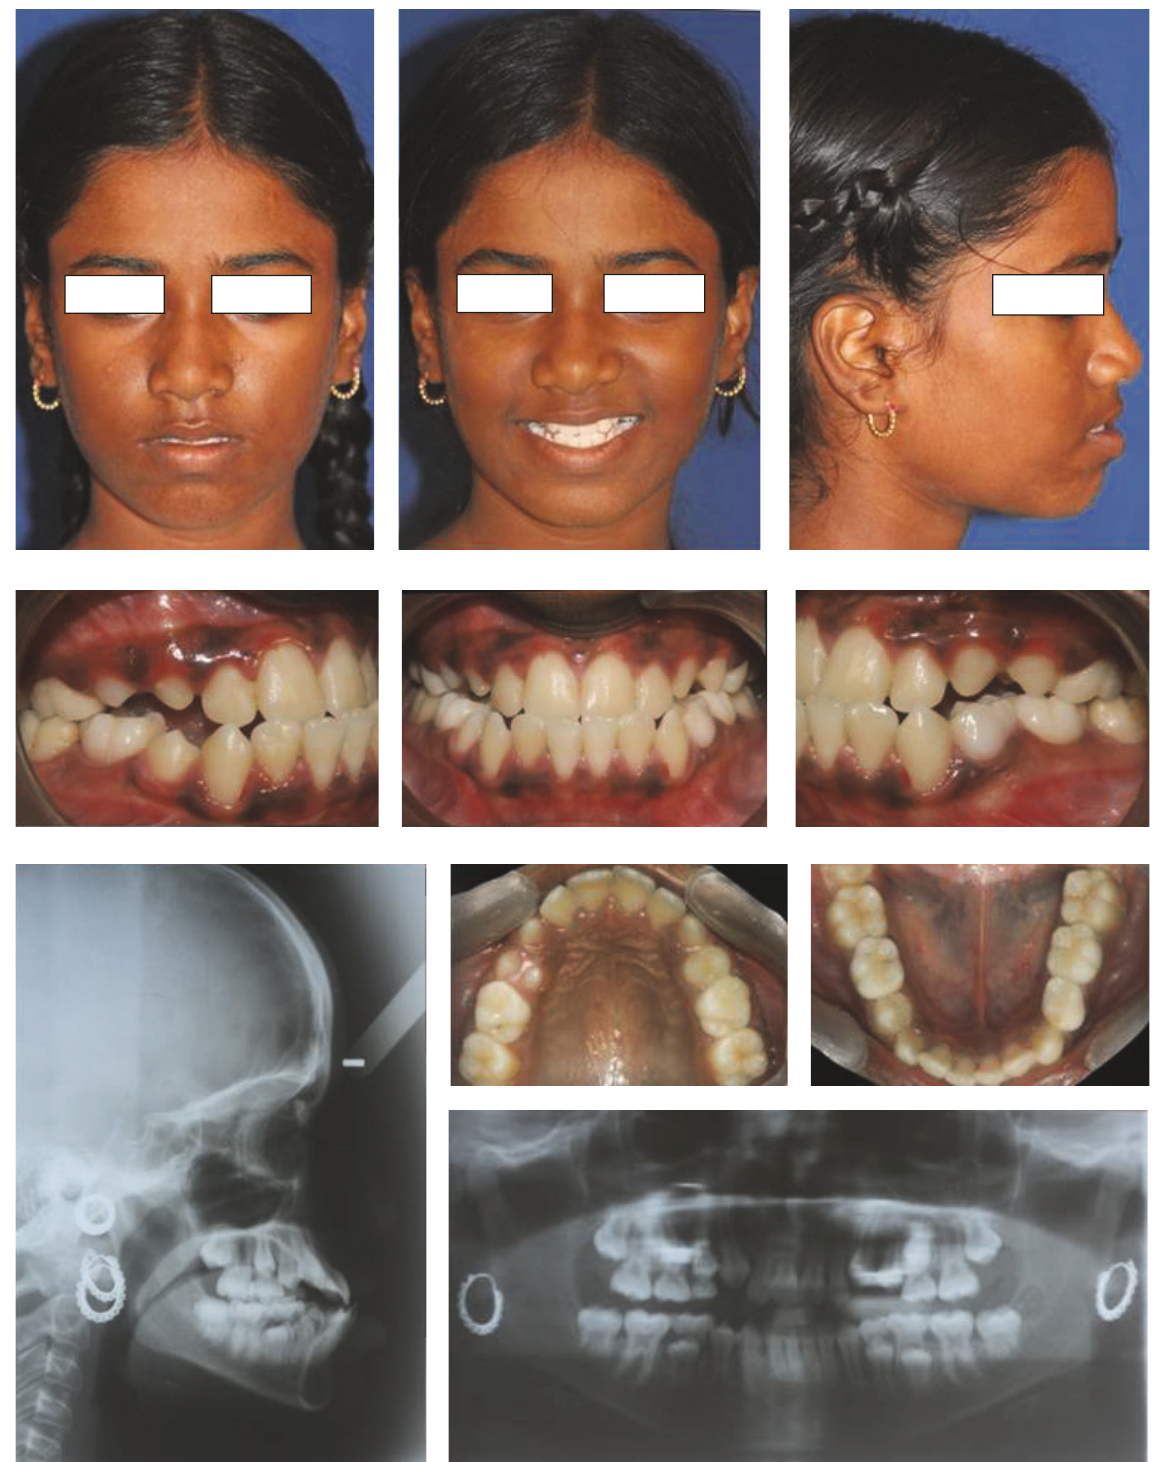
Figure 1: 12-year-old female patient with Class III dental and skeletal malocclusion, prognathic mandible, proclined lower incisors, and reverse